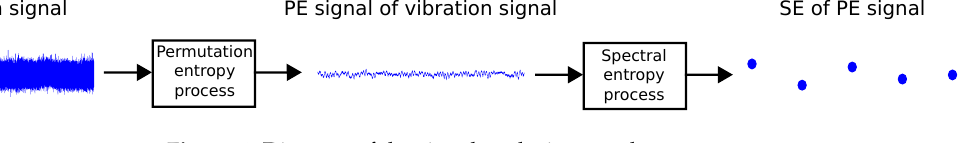
Figure 4. Diagram of the signal analysis